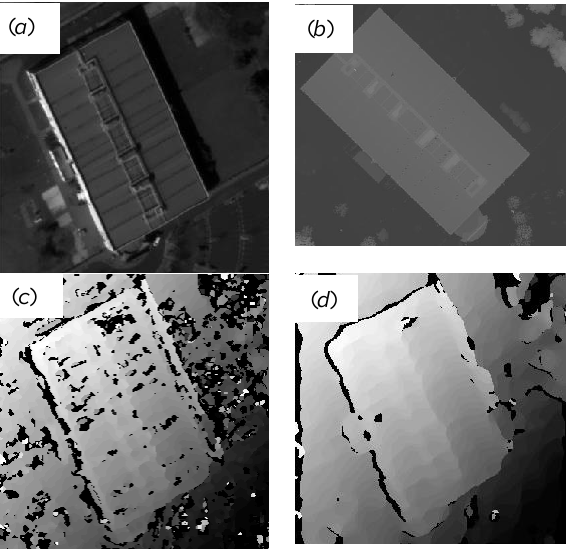
Figure 3: The effect on different support windows on the generated disparity maps by GF method with Census cost function. a) left epipolar image; b) LiDAR ground truth; c) and d) disparity maps by GF method with 13×13 and 31×31 support windows respectively.